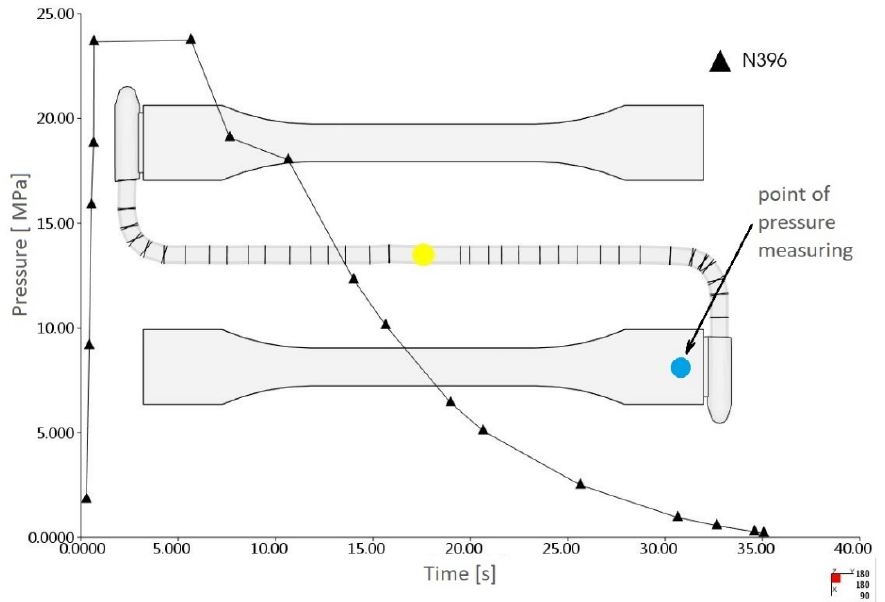
Figure 5. The pressure profile measured in the mesh FE node corresponding to the location of the pressure sensor.